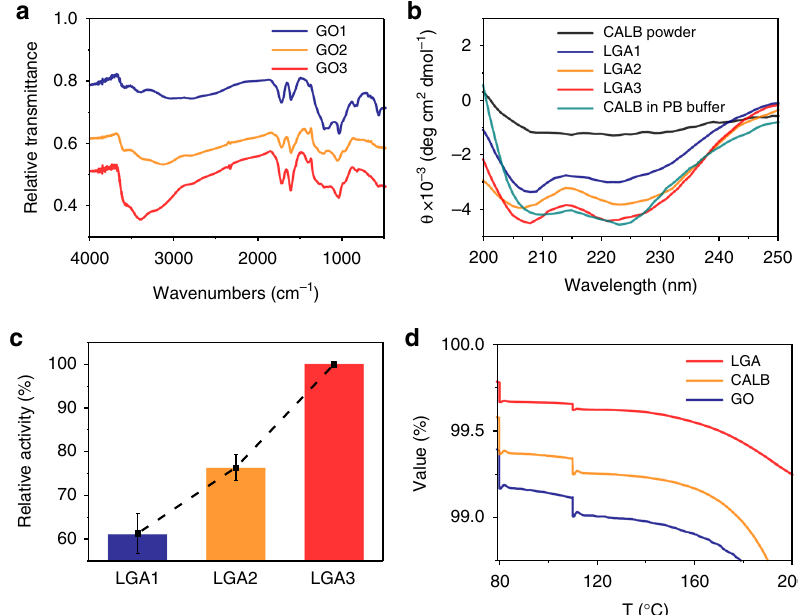
Fig. 5 Characterization for mechanism demonstration. a FTIR spectra of GO1, GO2 and GO3; b solid-state circular dichroism spectra of dry CALB, LGA1, LGA2, LGA3, and CALB in a phosphate buffer; c relative activity of LGA1, LGA2, and LGA3; d TGA results for LGA3, CALB, and GO. Error bars represent the s.d. of three replicates. Source data are provided as a Source Data fi